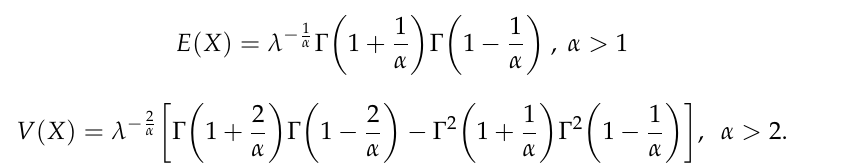
Figure 5. Hazard functions of the log-logistic distribution with parameters α and λ . The mode {(𝛼 − 1)/𝜆} (cid:2869)/(cid:3080) is denoted by circles. The 𝑝 -th quantile is 𝑥 (cid:3043) = [𝜆 (cid:2879)(cid:2869) 𝑝/(1 − 𝑝)] (cid:2869)/(cid:3080) . The mean and variance are, respec- tively,